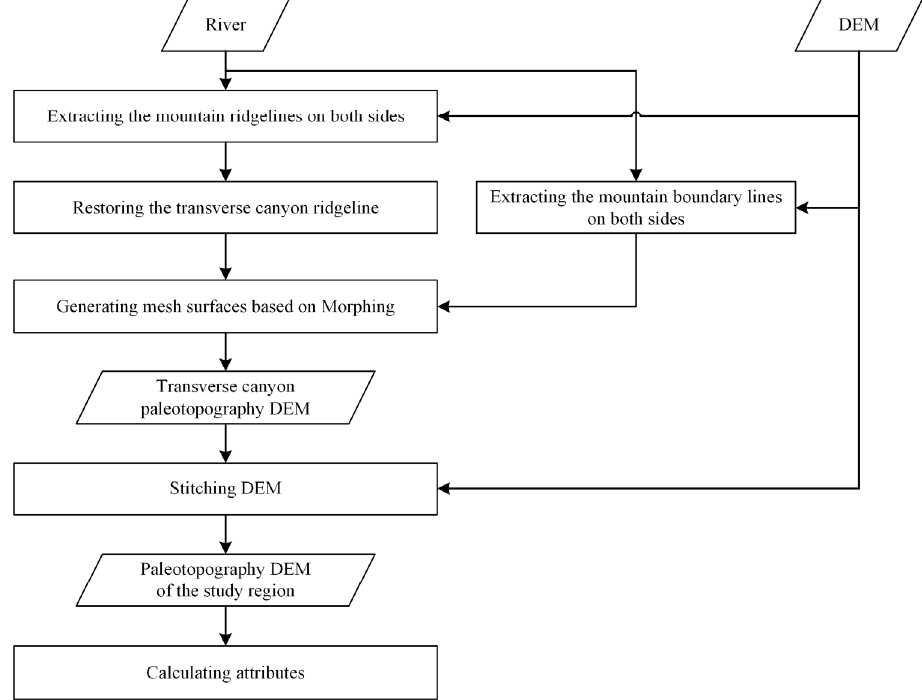
Figure 4. Flow chart of the transverse canyon reconstruction algorithm.